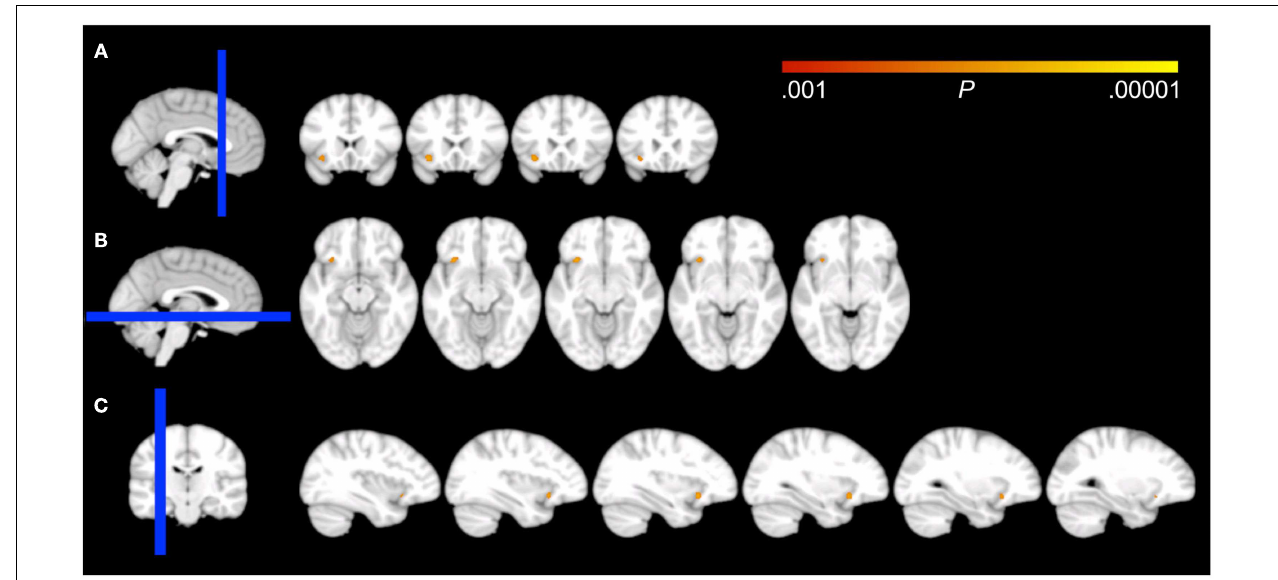
according to neurological convention (left = left).The blue bar in the localizer on the left side of the panels represents the slab of which slices are shown on the right. Note that the cluster overlaps the border of the inferior part of the orbitofrontal cortex and the most anterior aspect of the insular